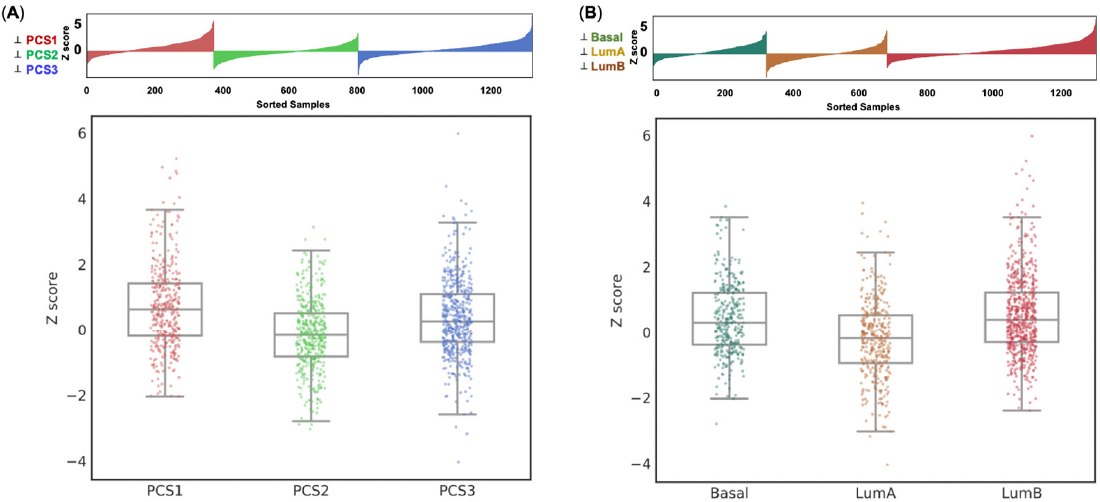
Figure 4. External validation. The expression of the 8-gene signature based on ( A ) PCS subtypes and ( B ) PAM50. The distributions of z-score transformed expression values in each group are shown in lollipop plot ( top ) and box plot ( bottom ). Higher expression of 8-gene signature in both aggressive subtypes (PCS1 and LumB) of two independent cohorts (PCS and PAM50) demonstrated the consistent results in external validation.